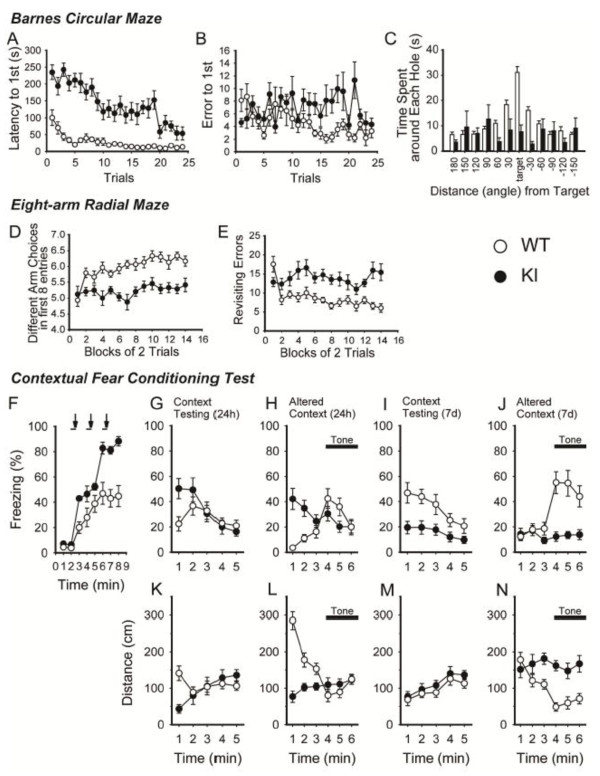
Impaired spatial learning and fear memory in the 1d2d-PSD-95-EGFP KI mice. A–C, Barnes circular maze (WT, open circles, n = 15; KI, filled circles, n = 16): latency to reach the target hole (A) and number of errors before reaching the target hole (B) across the training sessions were counted. Time spent around each hole in the probe test conducted after 24 trials, as shown in A and B was recorded (C). D–E, Eight-arm radial maze (WT controls, open circles, n = 15; KI, filled circles, n = 12): KI mice showed low levels of different arm choices in the first 8 entries (D), and increased revisiting errors (E) during training. F–N, Contextual fear conditioning test. In the fear conditioning phase, KI mice (filled circles, n = 12) showed higher freezing responses than WT controls (open circles, n = 15) (F). Horizontal bars denote exposure to the conditioning stimulus (tone), and arrows indicate the timing of the unconditioned stimulus (footshock). Freezing behaviors and distance traveled in the context test at 24 h after fear conditioning (G, K). Freezing behaviors and distance traveled in the cued test with an altered context at 24 h after fear conditioning (H, L). Freezing behaviors and distance traveled in the context test at 7 days after fear conditioning (I, M). Freezing behaviors and distance traveled in the cued test with altered context at 7 days after fear conditioning (J, N).